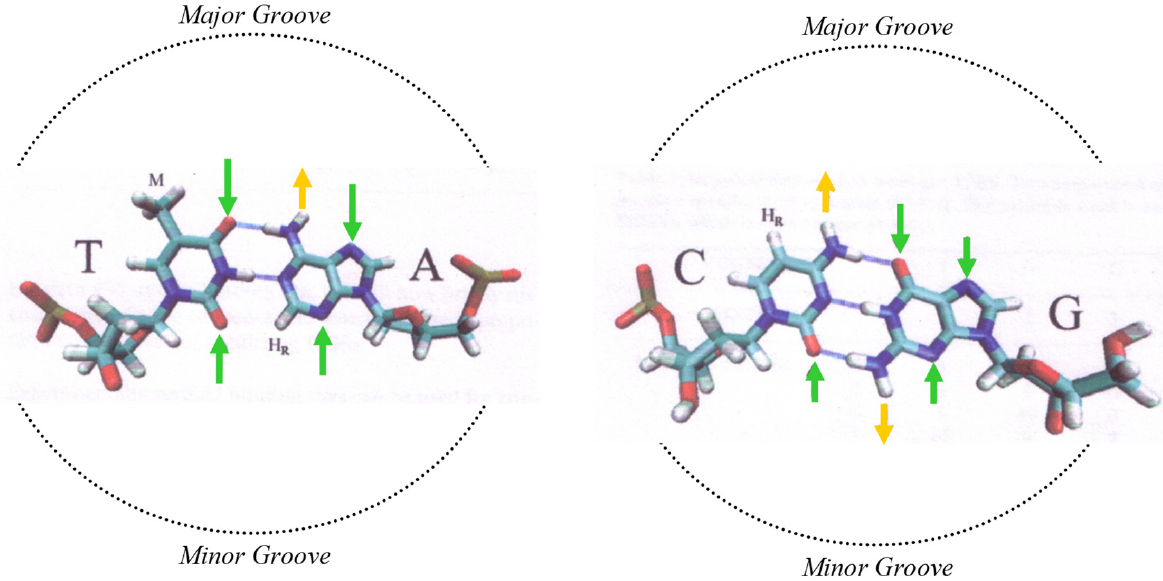
Figure 1. Diagram of base pairs of DNA, and recognition patterns for hydrogen-bond donor and acceptor sites. This is adapted from a diagram by Höglund et al., 2004 [30] (see Appendix A for article URL and licensing). These patterns are shown for the major and minor grooves of B-DNA. The four DNA bases, A, T, C and G, each contain distinctive and yet overlapping chemical and physical properties. There are three separate categories of property: The first is the weak or strong hydrogen-bonding capacity of the DNA bases. This is with reference to the number of hydrogen bonds between the base pairs of the DNA. A and G are weak (W) bases because these contain only two hydrogen bonds between the complementary base pairs, and C and G are strong. The second category is the purine or pyridine structural property. The DNA bases contain either a two-ring or one-ring molecular structure. The two-ring structures are called purines, and A and G are purines (R). The one-ring structures are pyrimidines; C and T are pyrimidines (Y). The third property is the chemical property of an amino or keto group. The bases each contain one of these. The bases A and C contain an amino (M) group, whereas G and T contain a keto (K) group. This affects the hydrogen-bonding capability of the bases, and, specifically, the hydrogen-bonding donor/acceptor patterns positioned at the major groove of the DNA. Hydrogen-bond acceptors are shown by green arrows and donors are shown by yellow arrows. In the minor groove, it is only possible to distinguish a C-G base pair from a T-A base pair via these hydrogen-bonding patterns. In the major groove, it appears possible to distinguish all four